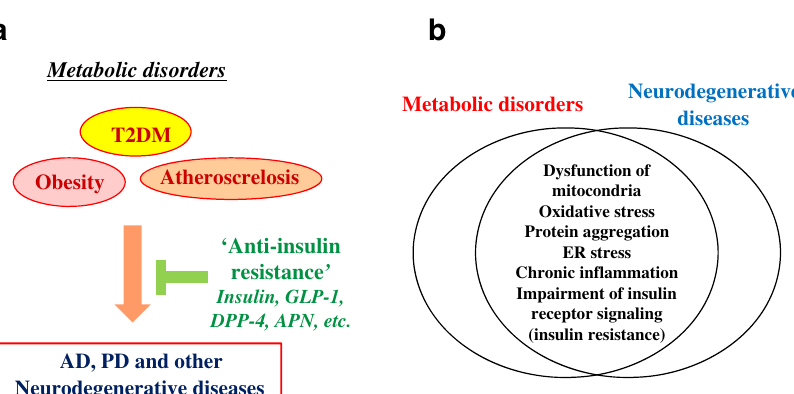
Fig. 3 Metabolic dysfunctions exacerbate neurodegenerative diseases. a A schematic fi gure showing that neurodegenerative diseases, including AD and PD, are stimulated by metabolic disorders, such as obesity, T2DM and atherosclerosis. Accordingly, “ anti-insulin resistance ” therapies, including insulin, GLP-1, dipeptidyl peptidase-4 (DPP-4) and adiponectin (APN), are therapeutic strategies against neurodegen- erative diseases. b A schematic fi gure showing that some pathogenic mechanisms are overlapped between metabolic disorders and neurodegenerative diseases. These include mitocondrial dysfunction, oxidative stress, protein aggregation, ER stress, chronic in fl ammation, impairment of insulin receptor signaling (insulin resistance),